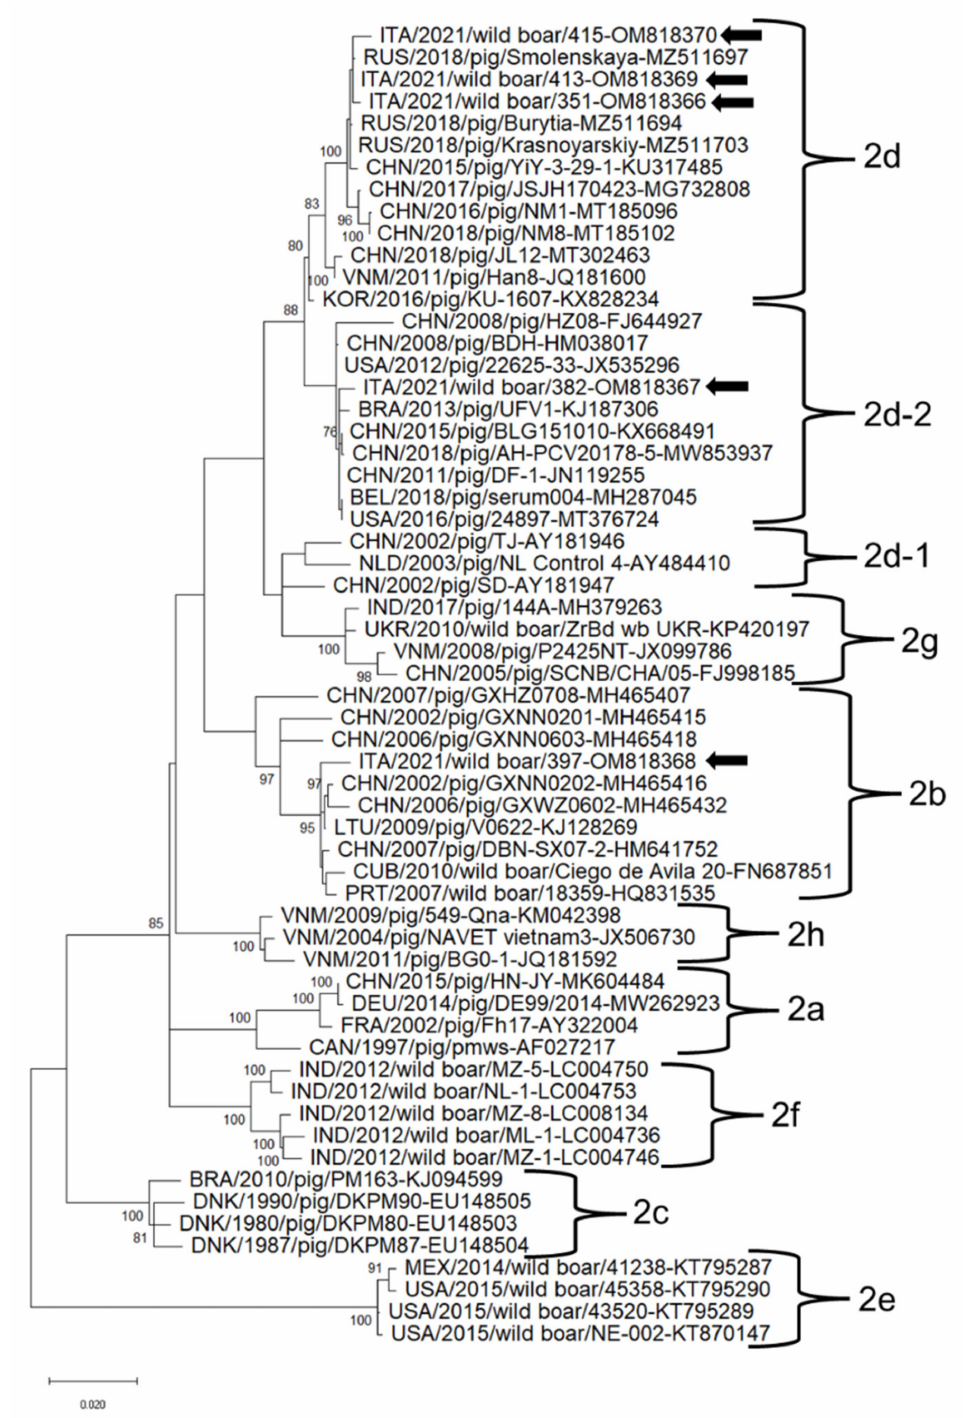
Figure 2. Full-genome-based unrooted phylogenetic tree Porcine circovirus 2 strains identified in this study and reference strains recovered in the GenBank database. The Maximum Likelihood method and Tamura-Nei model (four parameters) with a gamma distribution and invariable sites were used for the phylogeny. A total of 1000 bootstrap replicates were used to estimate the robustness of the individual nodes on the phylogenetic tree. Bootstrap values greater than 70% were indicated. Black arrows indicate strains detected in this study. Numbers of nucleotide substitutions are indicated by the scale